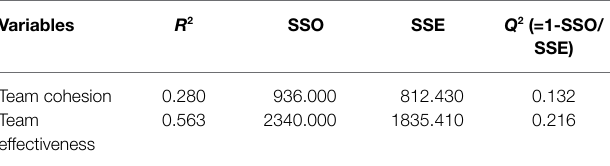
TABLE 4 | Explanatory power from R square and predictive power from the Q square of the endogenous latent variables.